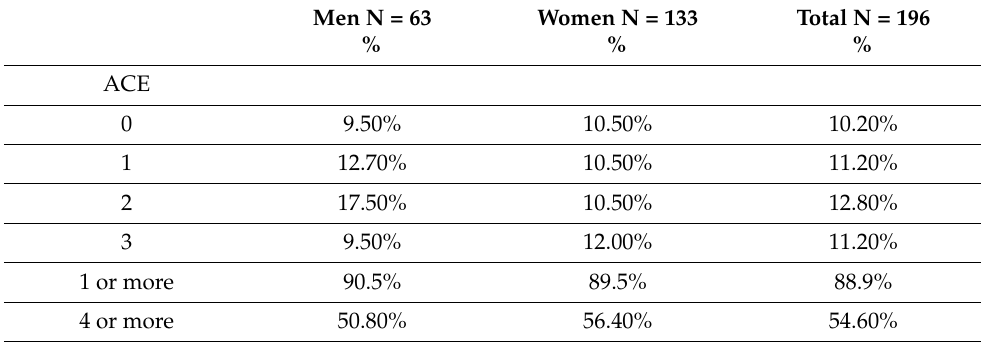
Table 1. Prevalence of